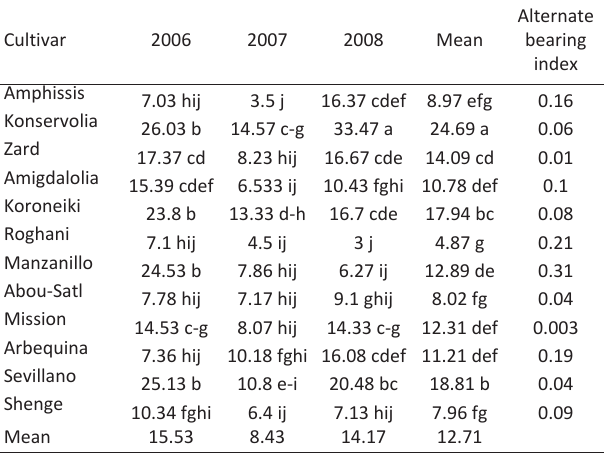
Table 5 - Fruit yield (Kg tree -1 ), mean yield (Kg tree -1 ) and Alternate Bearing index of olive cultivars during 2006-